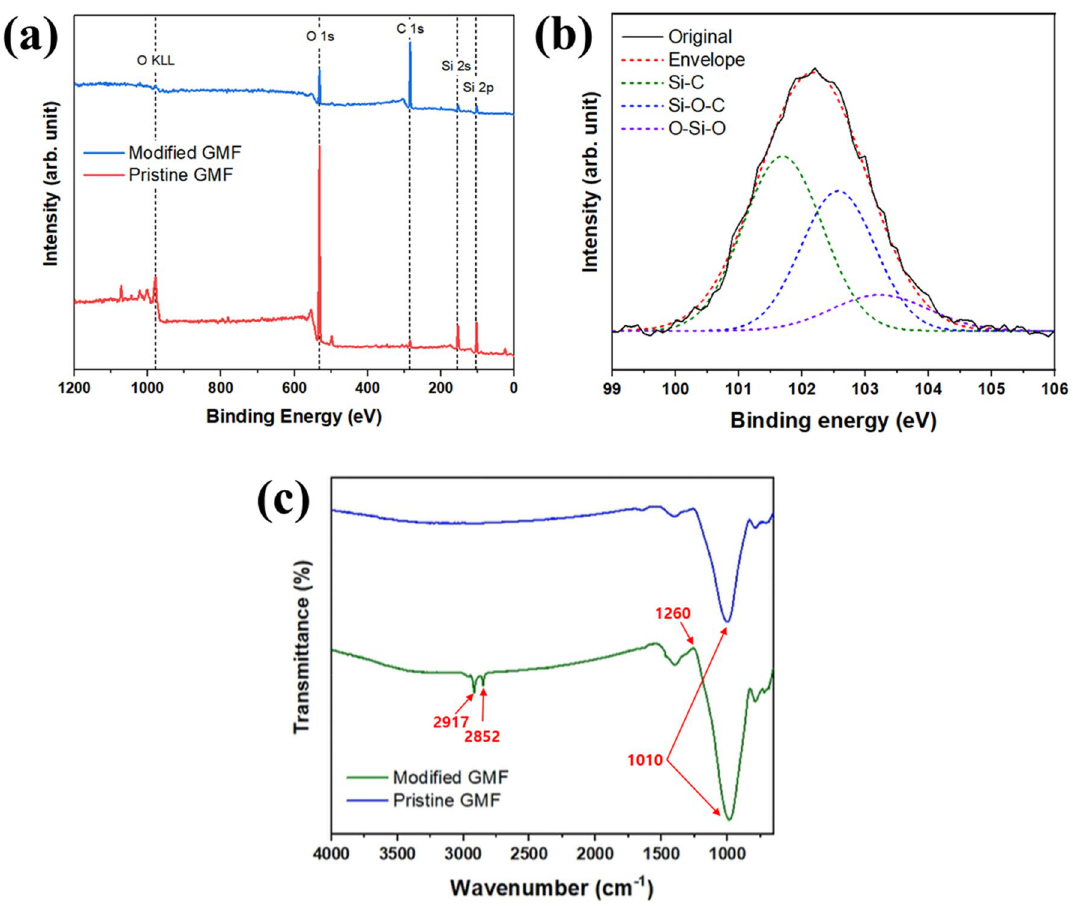
Figure 2. ( a ) Full high-resolution XPS spectra of pristine and modified GMF membranes. ( b ) Si 2p spectrum of modified GMF membrane. ( c ) FT-IR spectrum of pristine and modified GMF membranes.